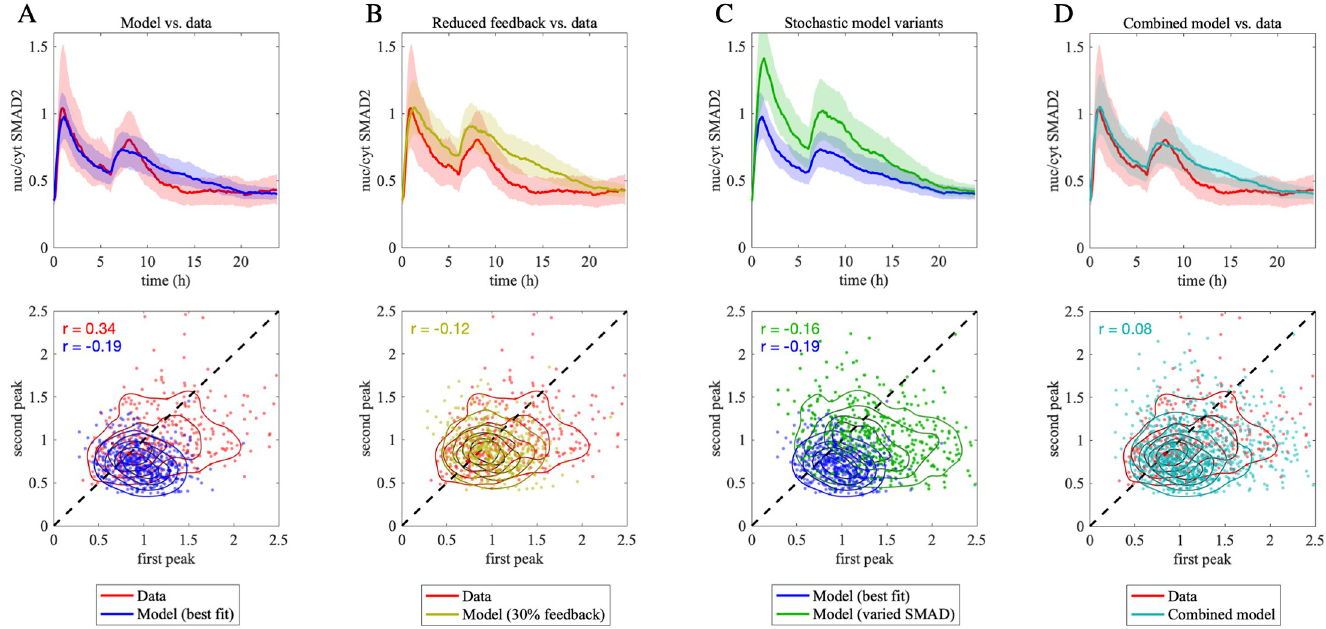
Fig 7. Contribution of temporally stable and unstable noise in restimulation experiments. A: Best-fit model fails to fully reproduce the restimulation response. Top: Population median of the nuc/cyt SMAD2 ratio in a restimulation experiment where cells were treated with 5 pM of TGF- β at experiment onset and after 6 hours. Experimental data (red) was compared to the best-fit internalization model (blue). Shades indicate the 25 to 75% quantiles. Bottom: Scatter plots comparing the height of the first peak (x-coordinate) with the height of the second peak (y-coordinate) in single cells, each dot representing one cell. The height of each peak in single cells was defined as the nuc/cyt SMAD2 ratio at the peak times in the population-average (55 minutes and 8h, respectively). Contour lines show the two dimensional densities of the cell population. The first and the second peak show a positive correlation in the data (Pearson correlation r = 0.34) but a negative correlation in our simulation (Pearson correlation r = -0.19). B: Model with reduced feedback strength shows less pronounced refractoriness to restimulation. Same as in A, but the experimental data is compared to the model with feedback induction ( P 39 in S1 Table) reduced by 70% (yellow). Compared to the orginal model (A), the population- average is increased, especially for the second peak, and the single-cell peak correlation is closer to 0 (Pearson correlation r = -0.12). Both indicate a reduced refractoriness to restimulation. C: Minor reduction in the initial SMAD4 level has pronounced effect on stochastic model behavior. The best-fit internalization model is compared to a model variant in which the total SMAD4 concentration is homogeneously reduced by 40% in all cells of the stochastic ensemble (dark green). A reduction in SMAD4 increases the nuc/cyt SMAD2 ratio by indirect effects on negative feedback regulation. D: A model comprising both temporally stable and unstable noise contributions provides a good match to the restimulation data. Artificial cell populations generated by the best-fit model (blue in panel C) and the model variant with reduced SMAD4 (green in panel C) were merged (cyan) and compared to the experimental data (red). The merged population reproduced the variability of the data and the positive correlation of the peak height (Pearson correlation r =